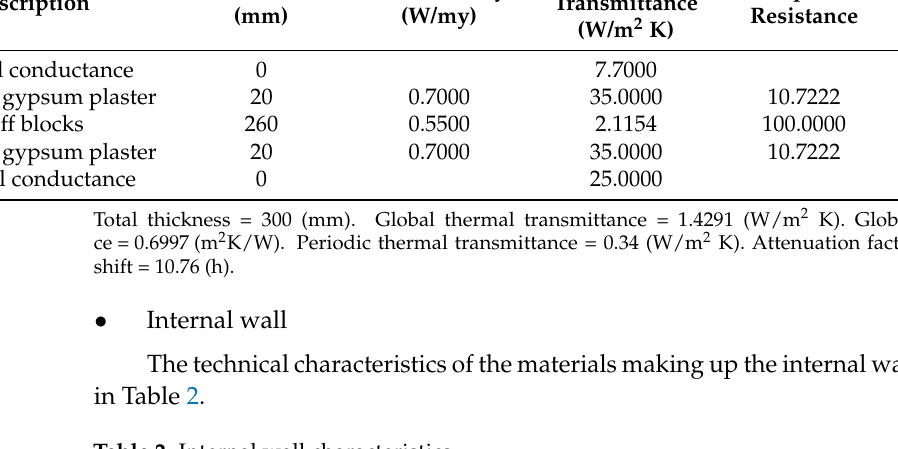
Table 2. Internal wall